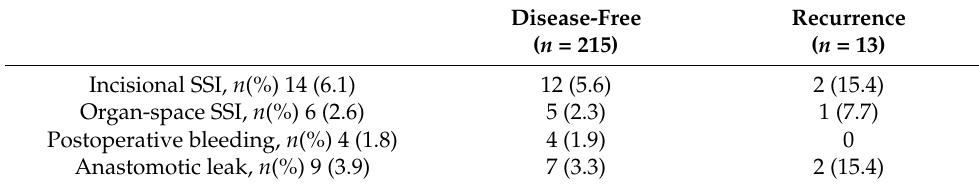
Table 3. Postoperative